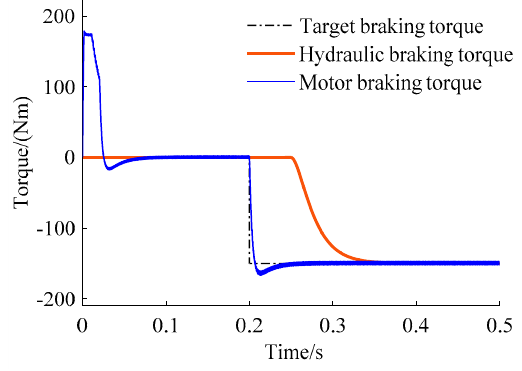
Figure 2. Step response of motor and hydraulic braking torque.